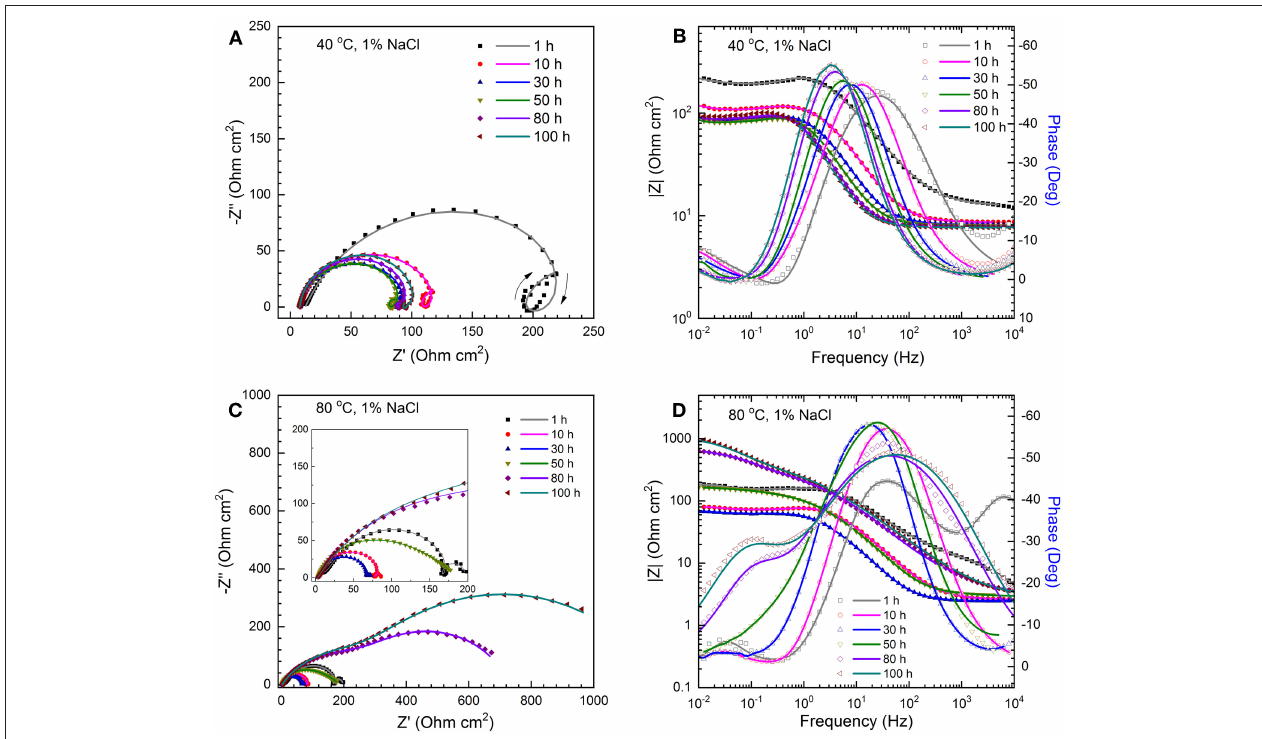
FIGURE 1 | The time-sequenced Nyquist plots (A,C) and corresponding Bode plots (B,D) for the C1018 steel samples tested in CO 2 -saturated 1% NaCl solutions at 40 ◦ C (A,B) and 80 ◦ C (C,D) . Scatter plots: measured; solid lines: